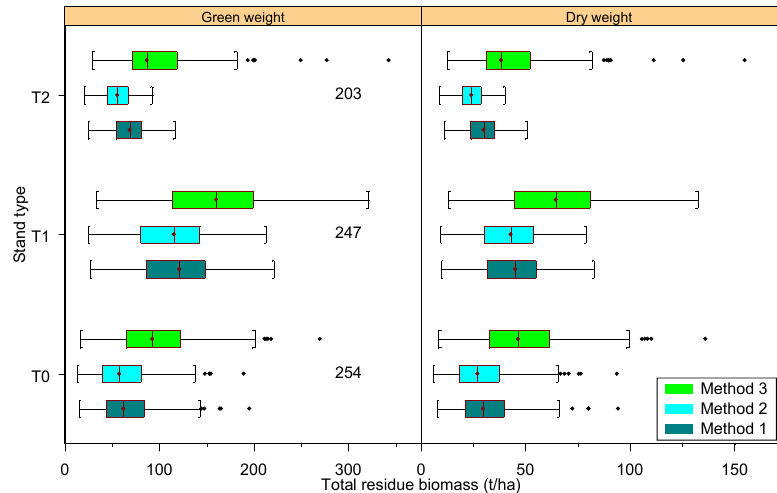
Figure 8. Boxplots of total residue biomass estimates in green and dry weight obtained through the three estimation methods for T0, T1, and T2 plantations. The numbers on the right-hand side of the left graphic panel indicate the total number of grid cells for each of the three stand types. Table 1. Estimates of total aboveground stand biomass (Total), total residue biomass (Residue), and its proportional allocation to the three residue components in green and dry weight that were obtained through each of the three methods (M) for the three stand types when averaged over grid